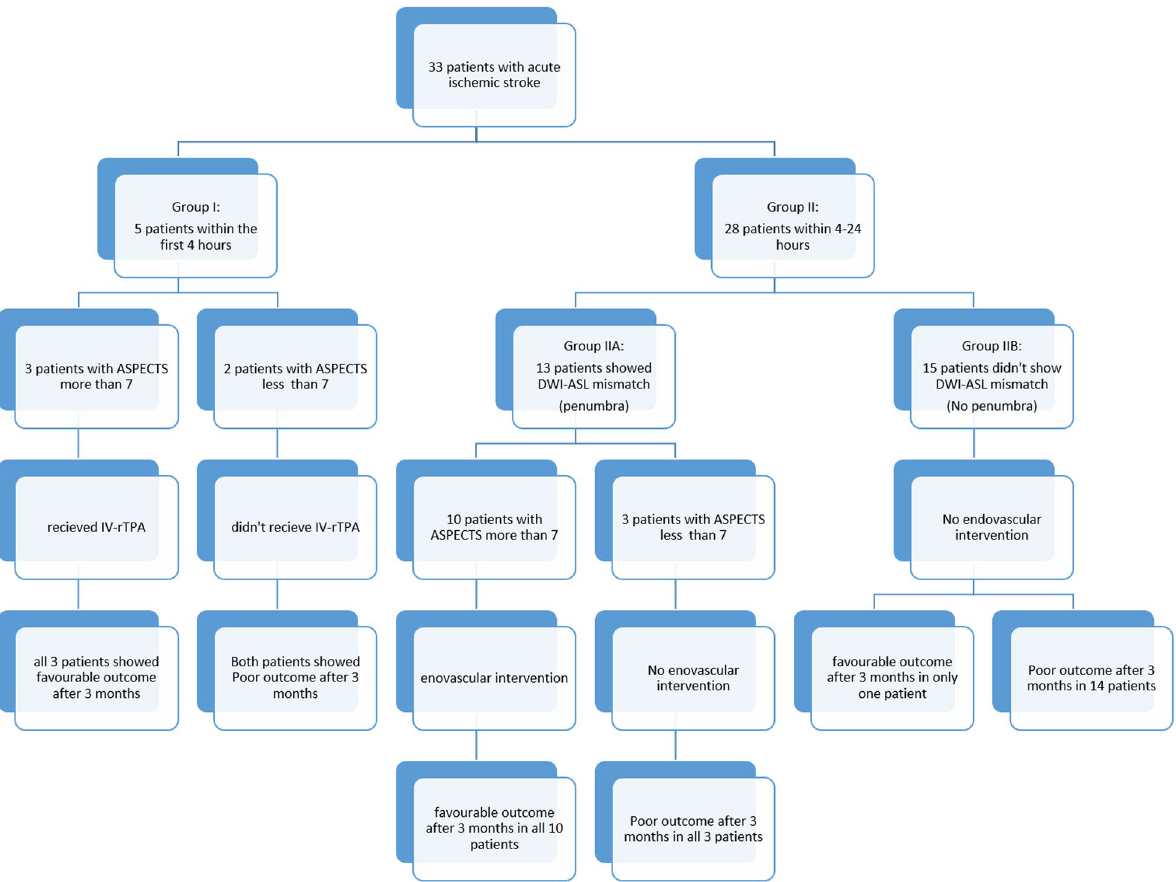
Fig. 4 Flow chart showing different acute stroke cases categories and their management and outcome (groups I, II A, IIB)